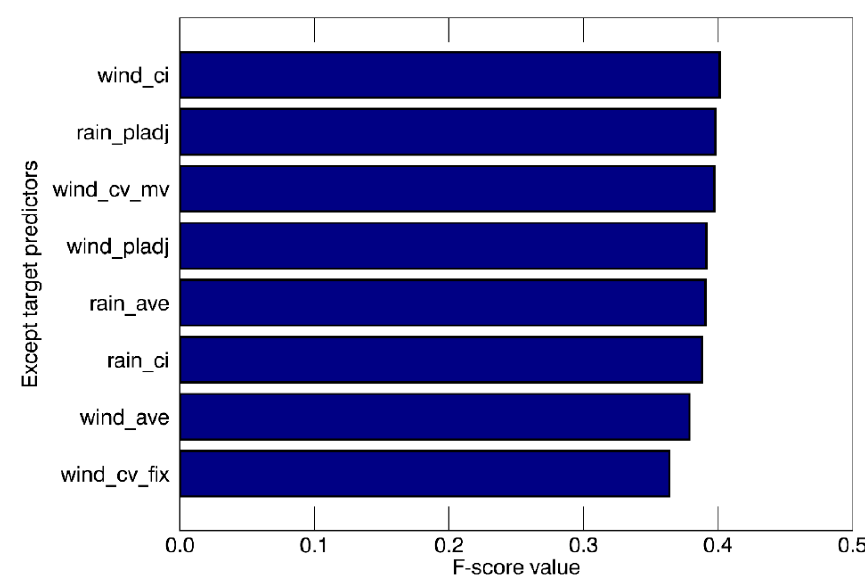
Figure 5. The average of F-score values in the training of the SVM model with the radial basis function. Each F-score value was obtained from the calibration using seven predictors without denoted target predictor.